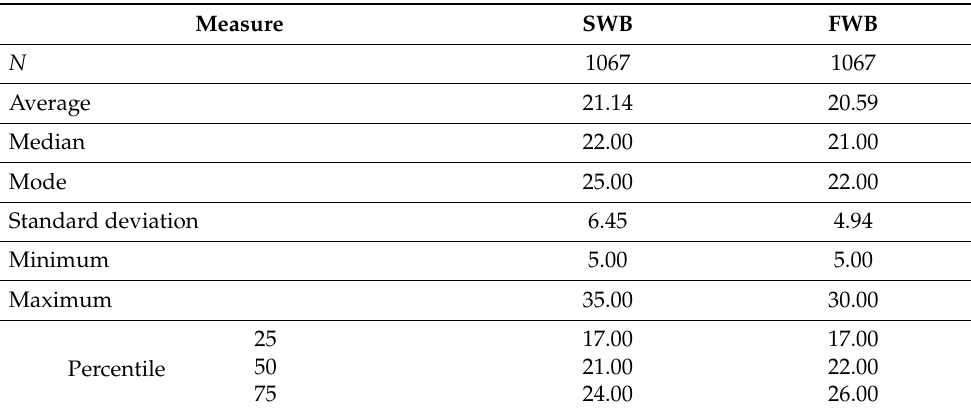
Table 2. Basic data concerning the level of SWB and FWB.